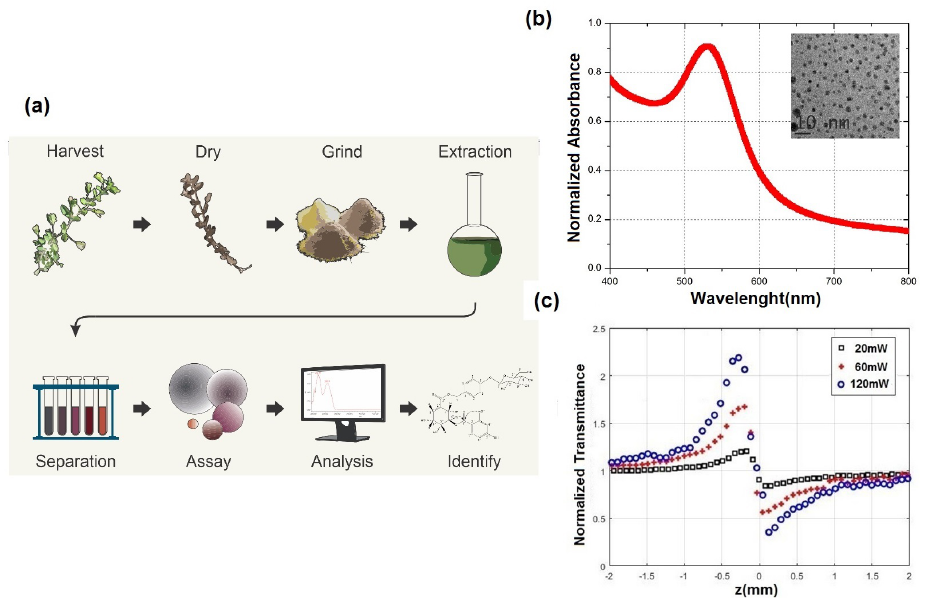
Figure 1. ( a ) Visual synopsis of the green synthesis method for gold nanocolloid preparation. ( b ) UV- vis normalized absorbance of the suspension versus wavelength; the inset is a TEM image of the nanoparticles. ( c ) z-scan data points showing the nonlinear transmission of the sample at λ = 532nm in the close aperture mode for various beam powers, as specified in the